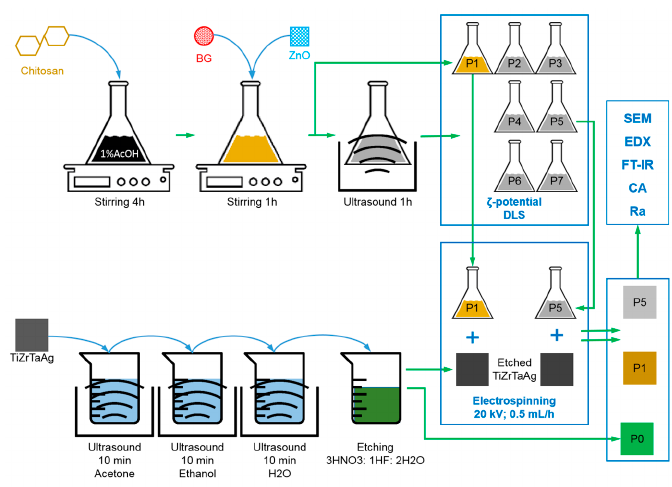
Figure 1. Schematic representation of sample preparation process.